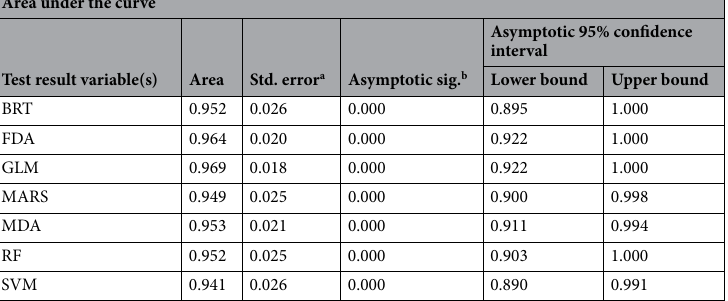
Table 5. Predictive performance of the seven applied models in the validation process of Landslides 2020. a Under the nonparametric assumption. b Null hypothesis: true area = 0.5.